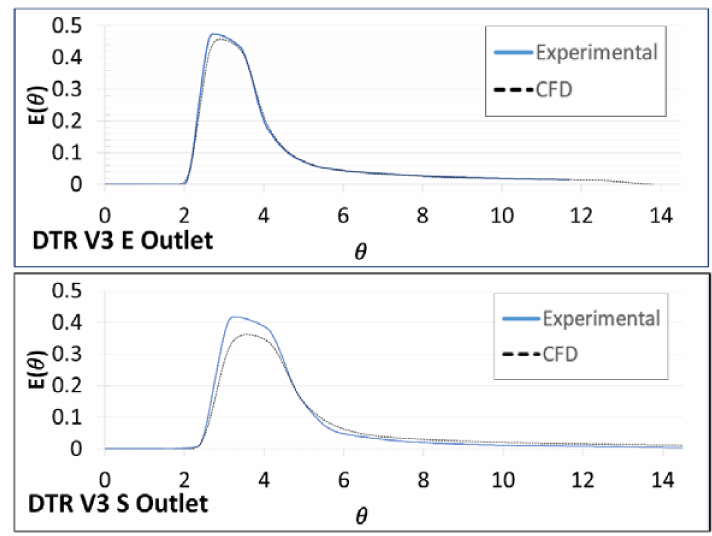
Figure 10. RTD curves for V3.